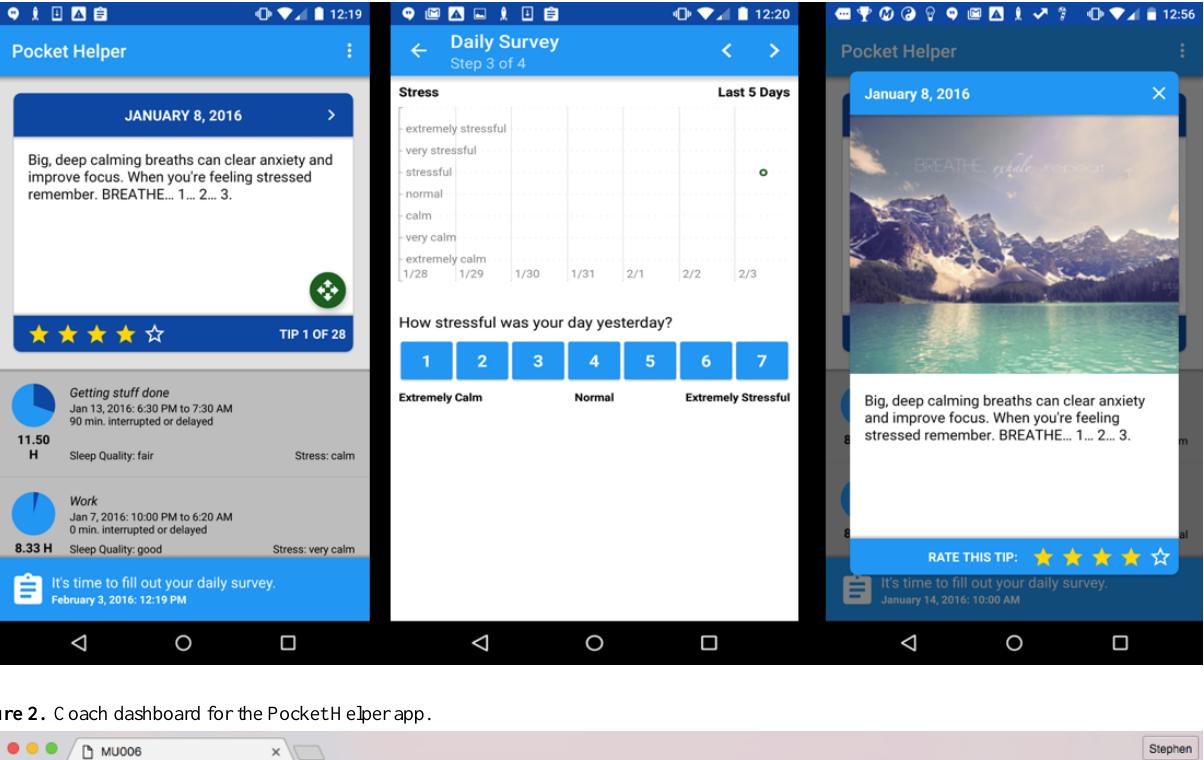
Figure 1. Screenshots of the Pocket Helper app.